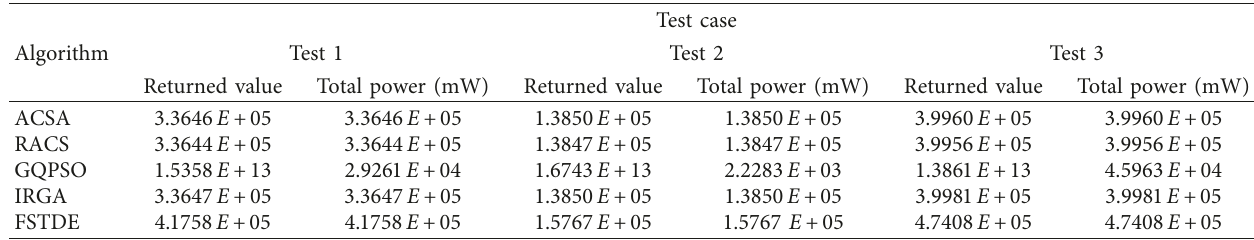
Table 18: Returned values and total power of ACSA and other advanced optimization algorithms in scenario 2 in three more test cases.